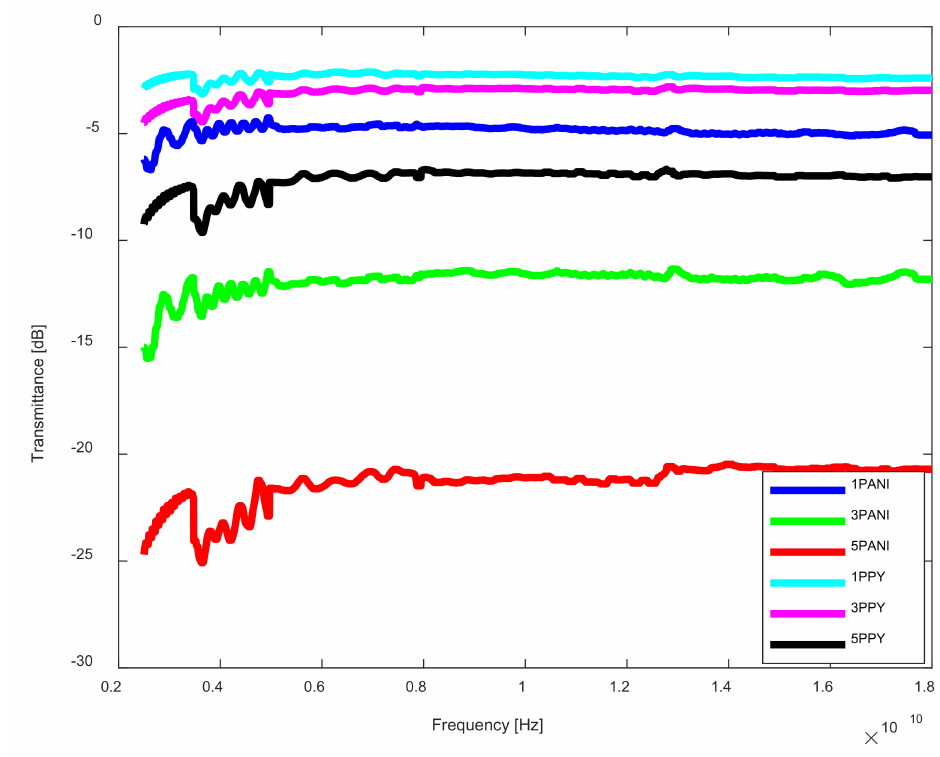
Figure 7. Results of measurements of transmittance in the tested frequency range from 2.5 to 18 GHz for textile samples printed with PANI and PPy conductive